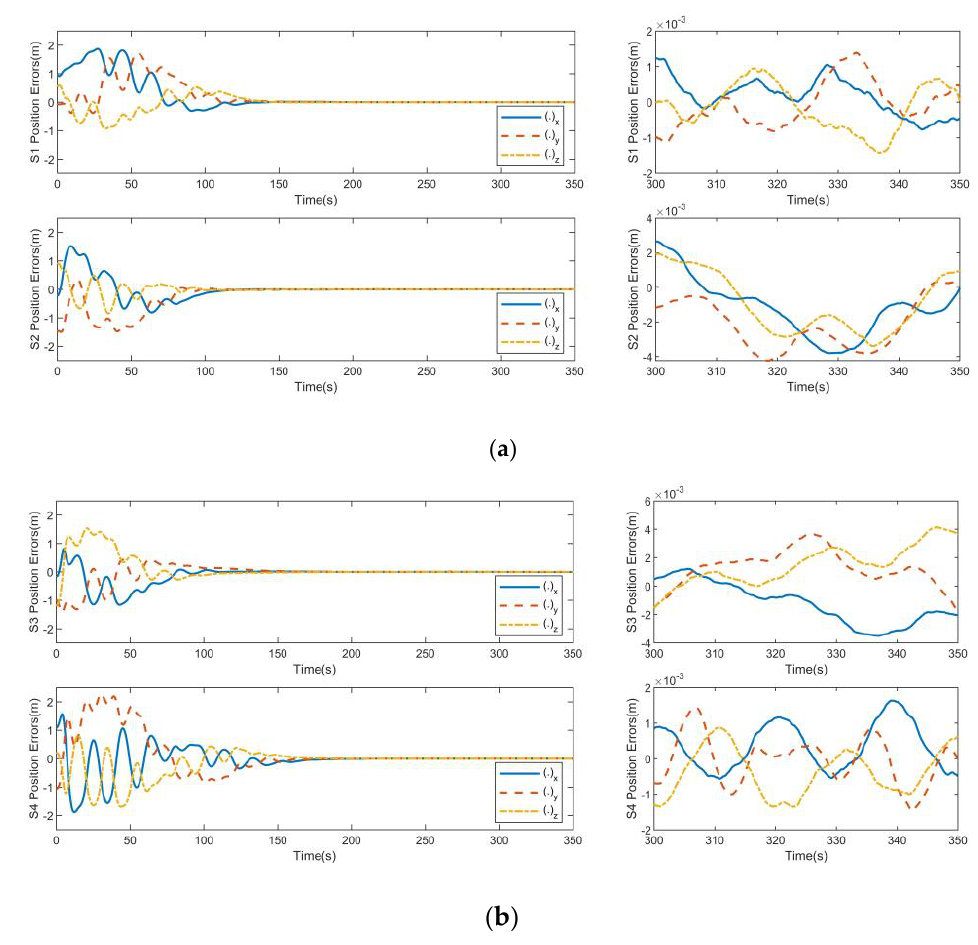
Figure 9. Position errors for consistent collaborative control : ( a ) S1 position errors and S2 position